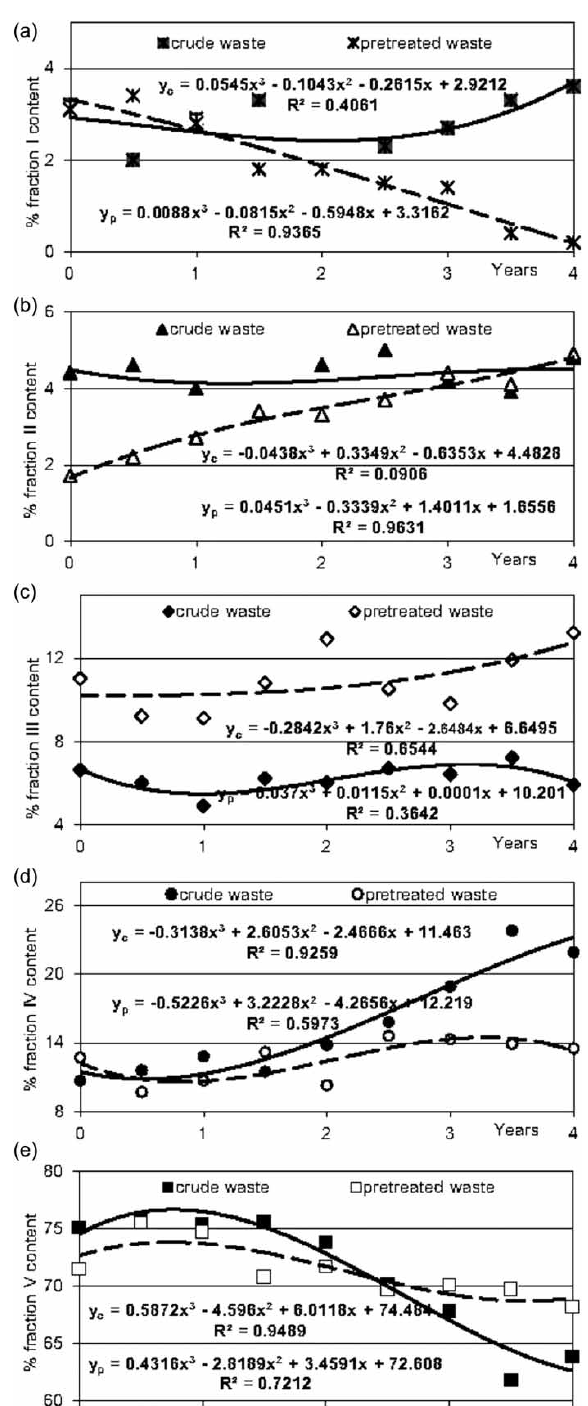
Fig. 3. Changes in the fractional content of chromium (Cr) in the surface layer of soil from the experimental plots irrigated and fertilized with mixed wastewaters from an oleo- chemical factory (cid:1) defatted raw (solid line of the trend (cid:1) y c ) and pretreated (broken line of the trend (cid:1) y p ) (C 0(Cr) (cid:1) 13.0 9 0.6 mg/kg d.m.). Individual fractions are given in diagrams: (a) fraction I (cid:1) exchanged, (b) fraction II (cid:1) carbonate, (c) fraction III (cid:1) connected with hydrated oxides of manganese and iron, (d) fraction IV (cid:1) organic, (e) fraction V (cid:1) the residual